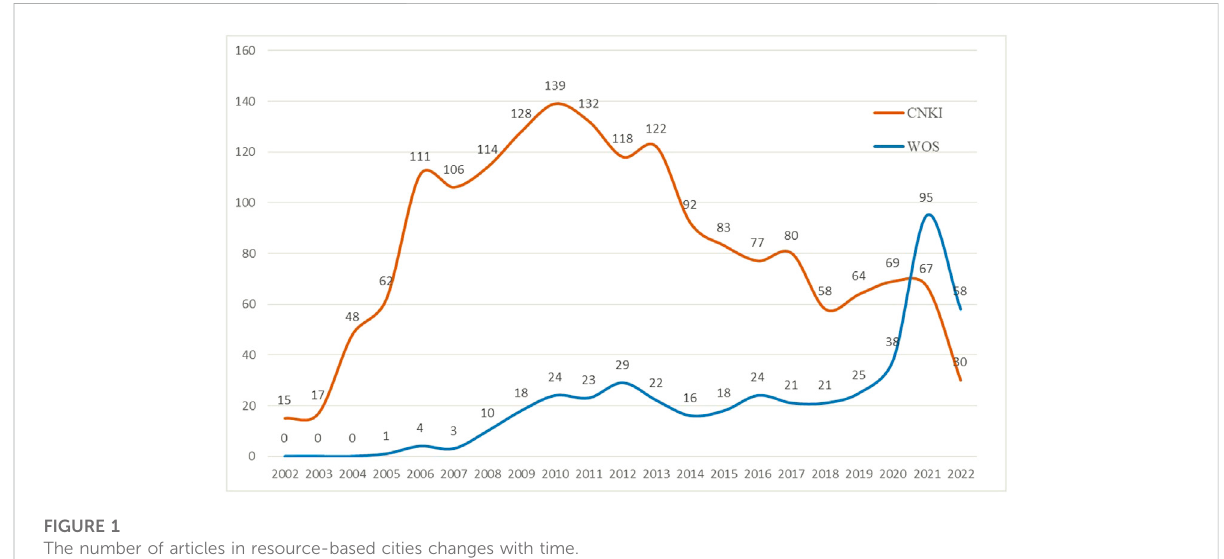
FIGURE 1 The number of articles in resource-based cities changes with time.